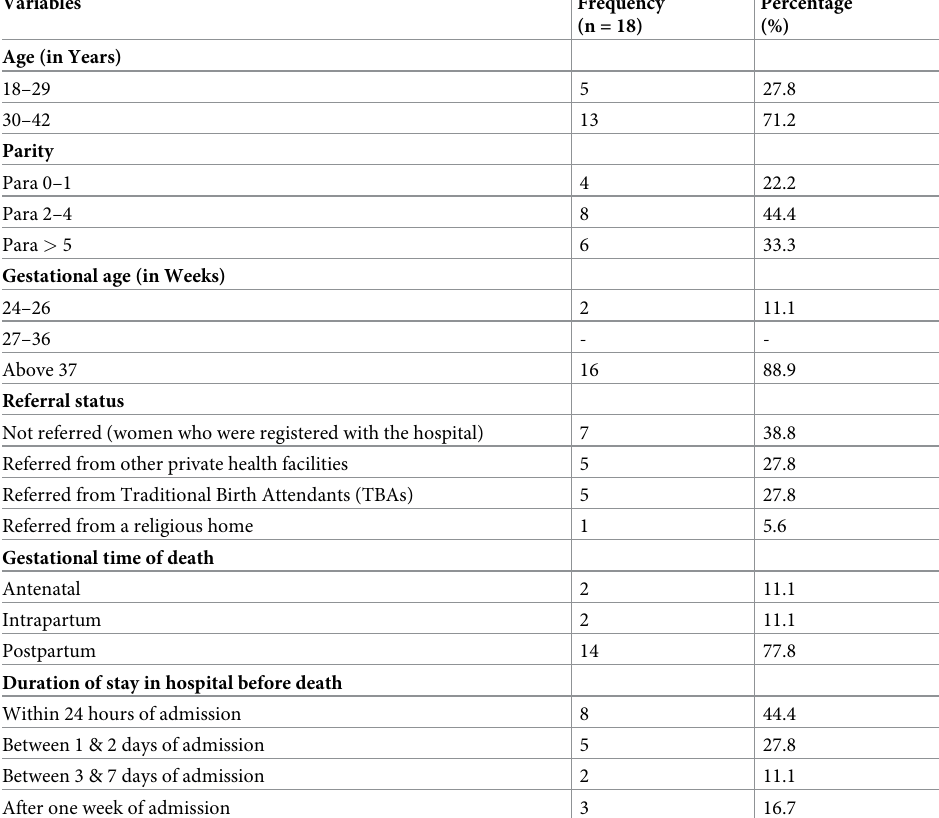
Table 1. Pregnancy-related characteristics of maternal deaths at the Central Hospital, Benin City (October 2017 – May 2019).